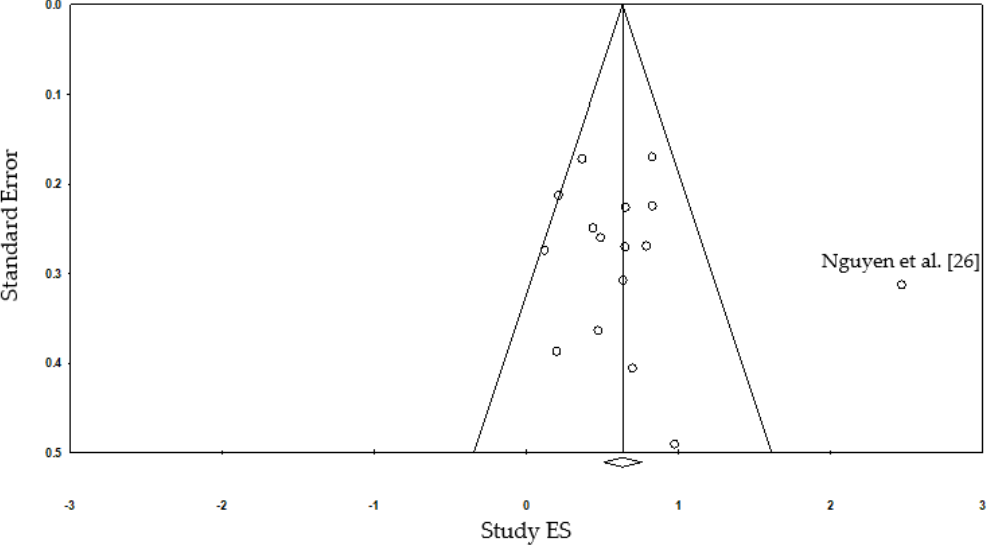
Figure 3. Funnel plot of study effect size (ES) vs. study standard error.